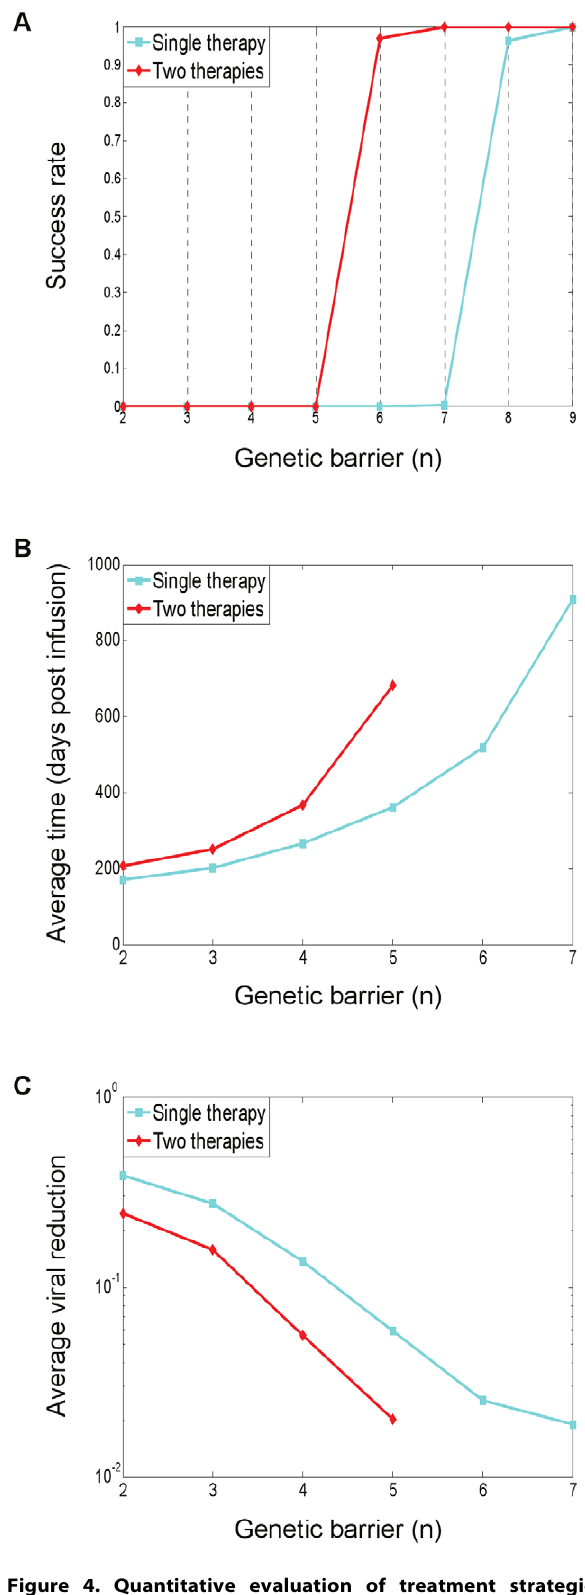
Figure 4. Quantitative evaluation of treatment strategies investigated in this study. Each point summarizes the average outcome of 500 simulations with default parameter values (see the Methods section). The blue curves correspond to a standard use of a single gene therapy (discussed in subsection ‘‘Emergence and